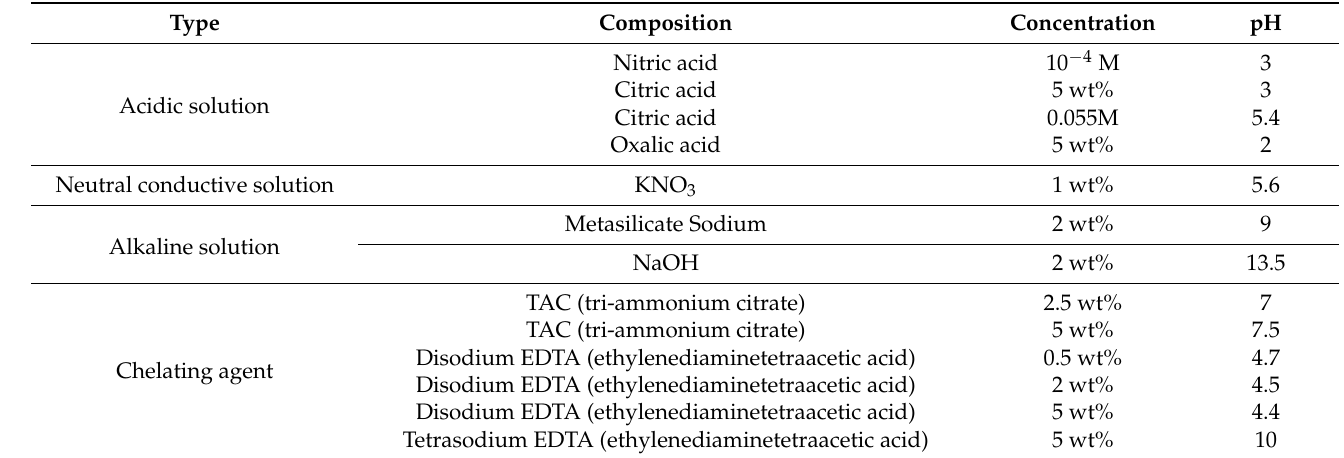
Table 2. List of treatment